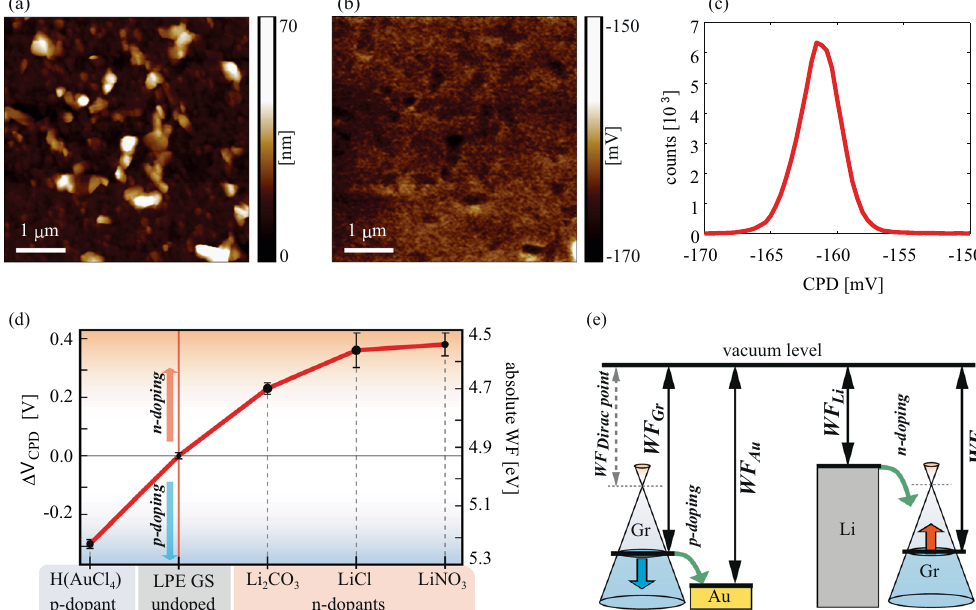
Figure 5. ( a ) AFM topography, ( b ) CPD map measured by KPFM, and ( c ) histogram of ( b ) shown for H(AuCl 4 ) doped LPE GS film as an example. ( d ) Change in WF for doped LPE GS films for different dopants, in comparison to the undoped LPE GS film. Solid red line in ( d ) is only a guide for the eye. ( e ) Schematic representation of the work functions prior to the interaction (equal vacuum levels) for Au-based salt/graphene and Li-based salt/graphene. The green arrows indicate direction of electron flow showing that in the case of Li (Au) based salts, electrons are transferred to (from)